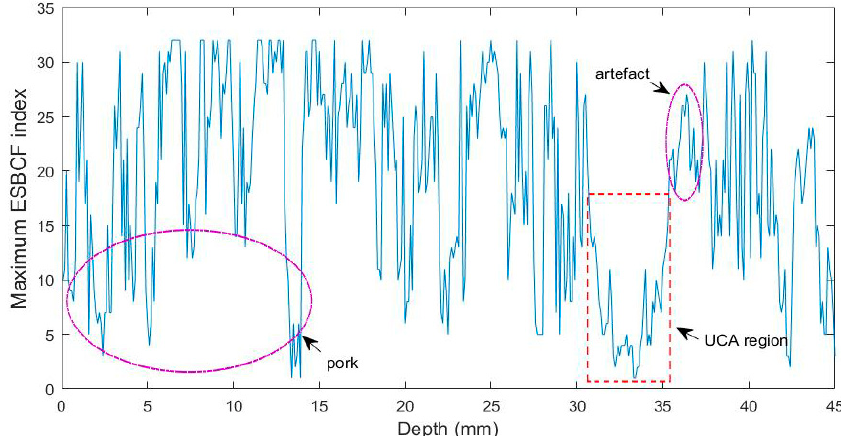
Figure 4. The maximum eigenspace-based coherence factor (ESBCF) value index curve of The maximum eigenspace-based coherence factor (ESBCF) value index curve of different depths. different